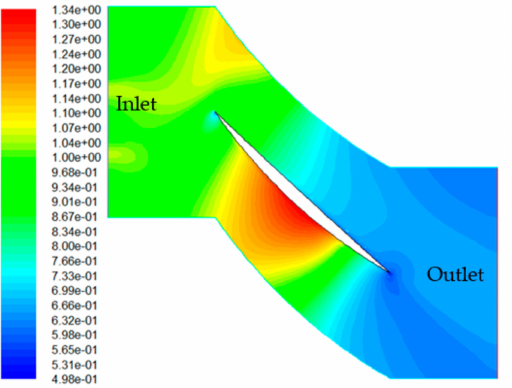
Figure 8. Contour of Mach number for a DCA blade cascade with transonic flow regime (Mach inlet =